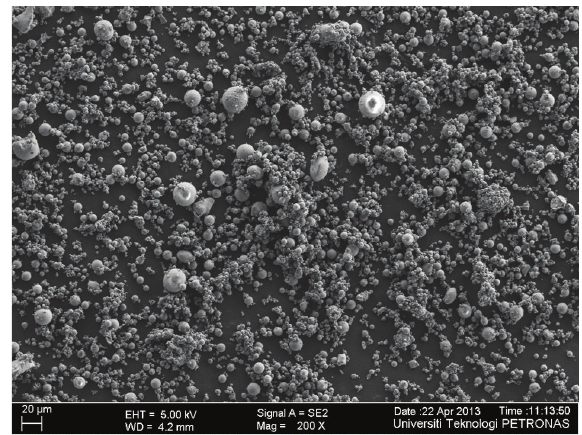
Figure 1: Microstructure of fly ash through field emission scanning electron microscope (FESEM) showing particle size distribution.